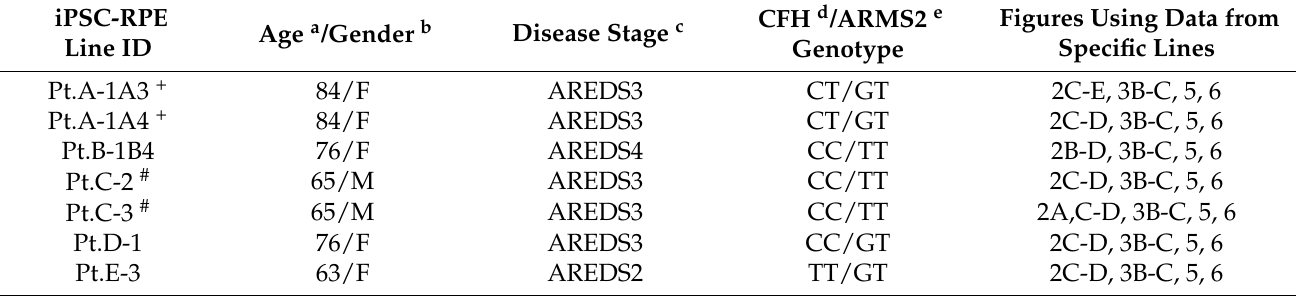
Table 1. Patient iPSC-RPE lines and donor